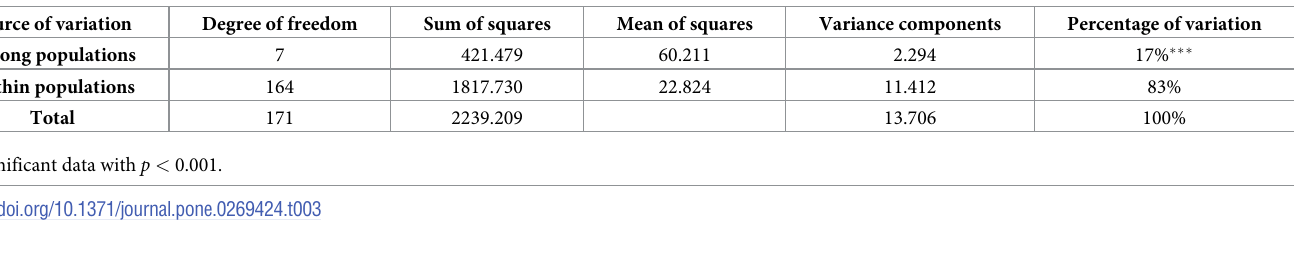
Analysis of genetic relationships of P . armeniaca var. ansu The UPGMA cluster analysis of 86 P . armeniaca var. ansu accessions based on SSR markers was shown in Fig 3. The genetic similarity coefficient ranged from 0.773 to 0.962. Entire acces- sions were could be divided into 4 groups (A, B, C, D in Fig 3), with a genetic similarity coeffi- cient of 0.826. The accessions in Group A were all from Xinjiang provenances, while the accessions in Groups B, C and D were all from northwest provenances. The cluster analysis result reflected the differences in P . armeniaca var. ansu accessions across provenances. Group A included 60 accessions, which can be divided into 3 subgroups. The first subgroup included